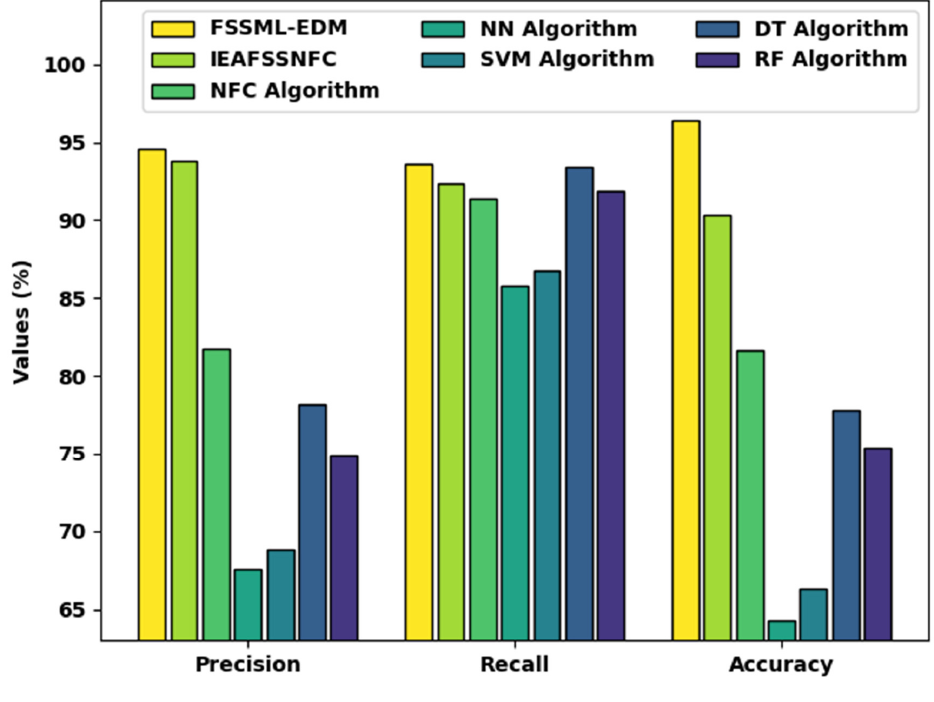
Figure 11. Prec n , reca l , and acc y analysis of FSSML-EDM technique. Figure 11. 𝑃𝑟𝑒𝑐 (cid:3041) , 𝑟𝑒𝑐𝑎 (cid:3039) , and 𝑎𝑐𝑐 (cid:3052) analysis of FSSML-EDM technique. Figure 12 inspects the comparative 𝐹 (cid:3046)(cid:3030)(cid:3042)(cid:3045)(cid:3032) , 𝑀𝐶𝐶 , and 𝑘𝑎𝑝𝑝𝑎 analysis of the